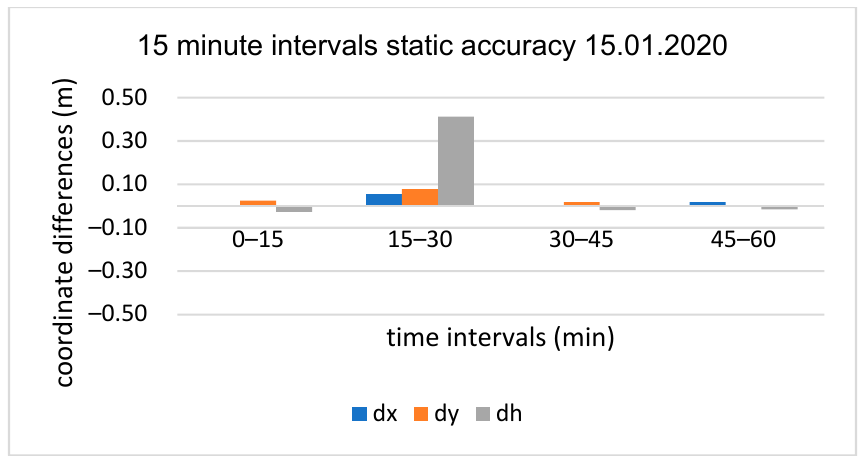
Figure 7. 15 min sub-session positioning results for initial test, baseline OPNT–P30Pro (4 km).